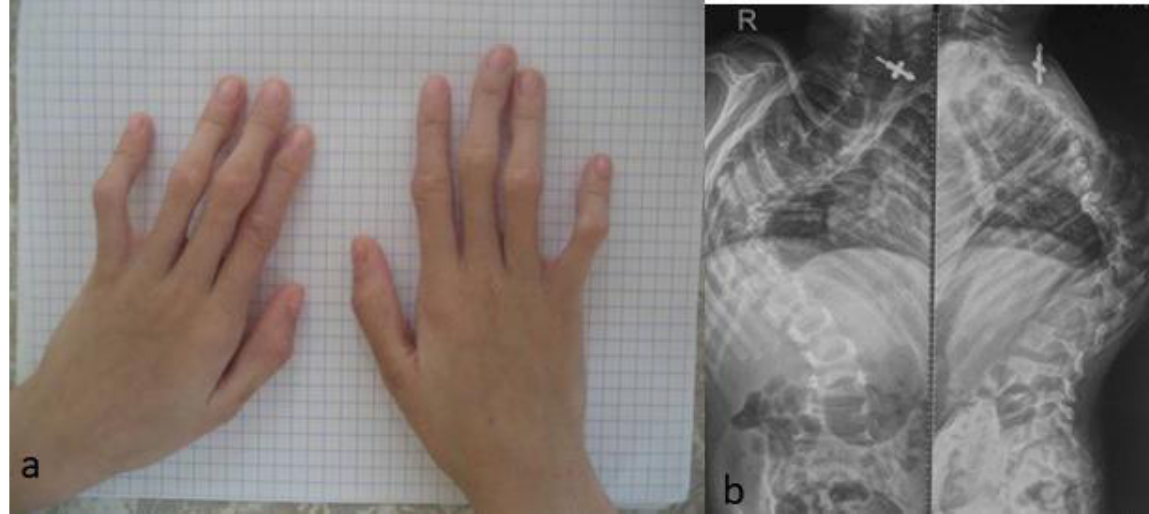
Figure 7. Arachnodactyly associated with camptodactyly of the 5th. Fingers, in a 4-year-old girl ( a ); AP and lateral spine radiographs showed kyphoscoliosis (Cobbs angle of 80°) ( b ).